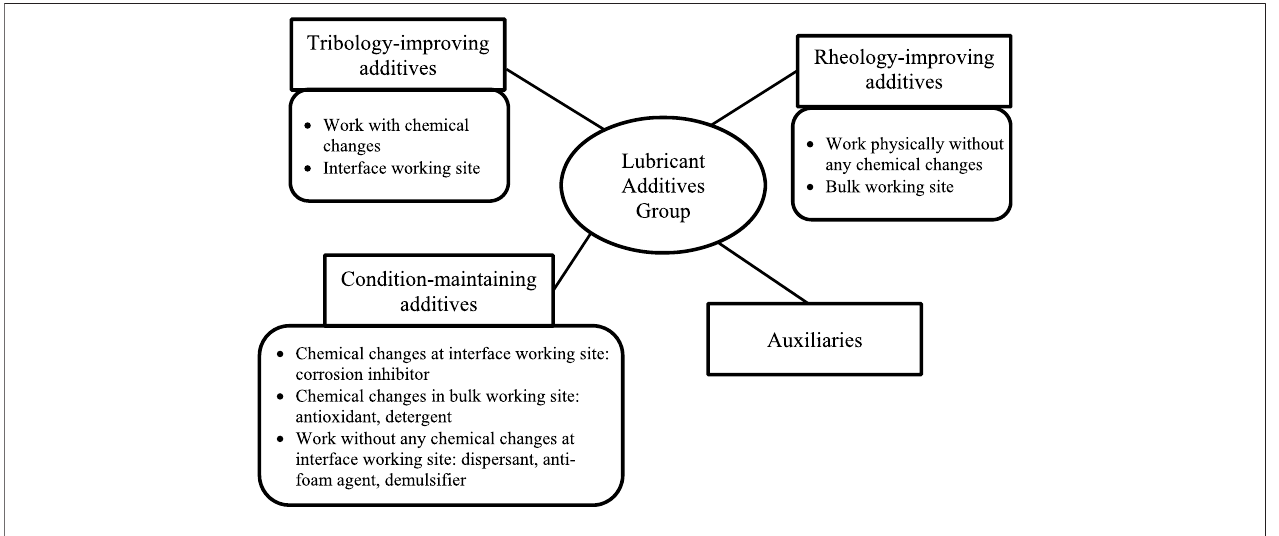
FIGURE 1 | Working function groups of lubricant additives (Minami, 2017).